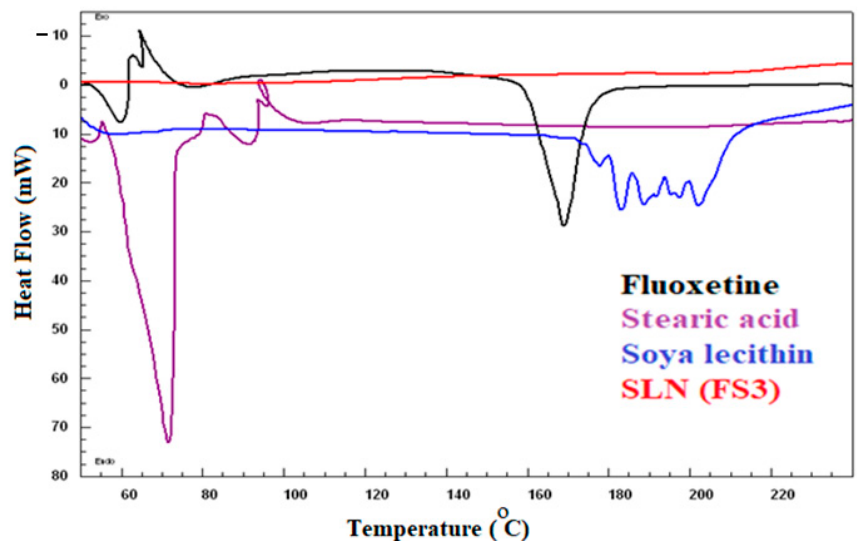
Figure 4. DSC thermograms of fluoxetine, Stearic acid Soya lecithin and optimized solid lipid nanoparticle (FS3).